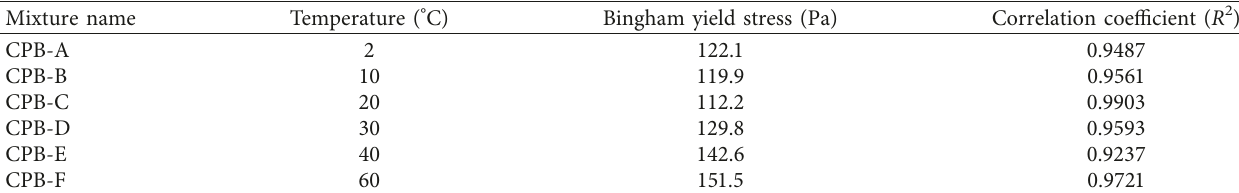
Figure 7: Effect of shear rate on shear stress of different paste temperatures. Table 3: The fitting parameters for different samples based on the Bingham